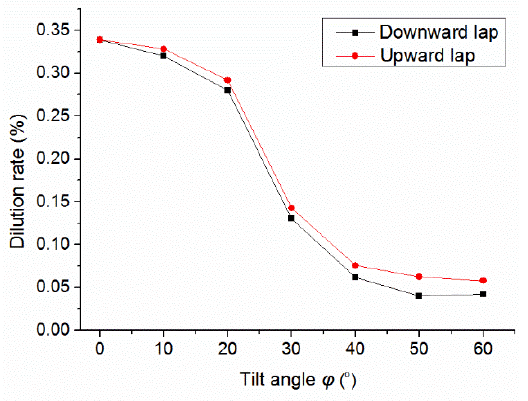
Figure 5. Influence of substrate tilt angle on dilution